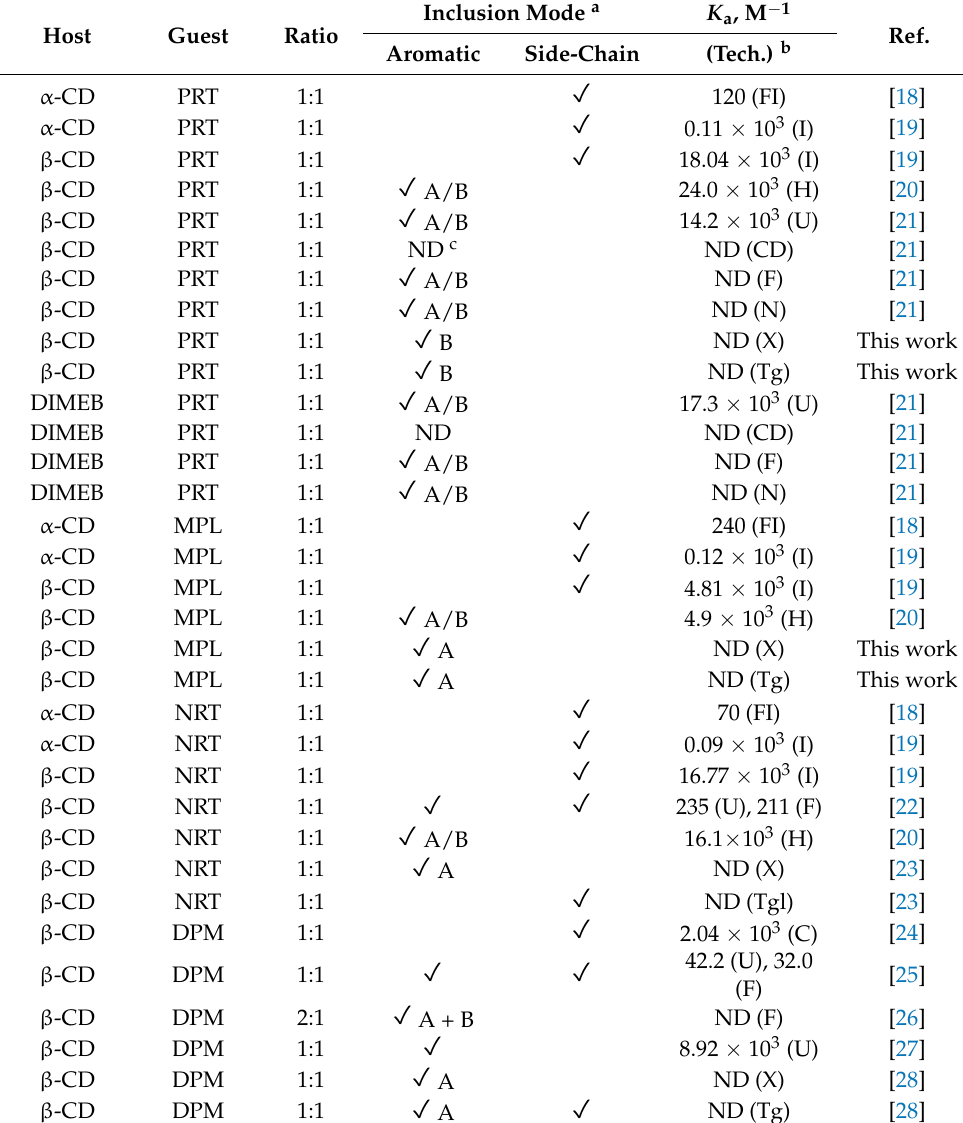
Table 1. Summary of the CD–2° amine TCA complexes characterized by various techniques.